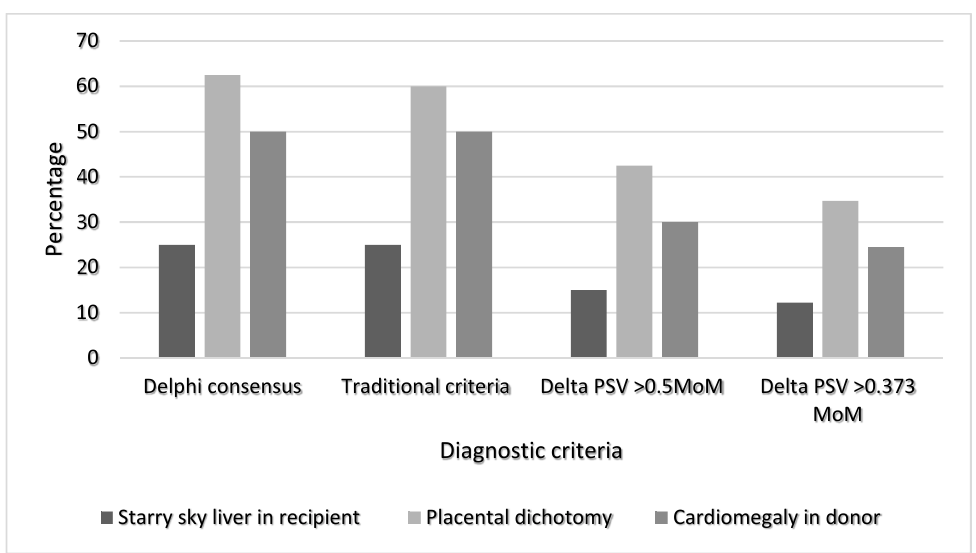
Figure 4. Bar chart showing the percentage presence of additional ultrasound markers such as starry sky liver in the recipient, placental dichotomy, and cardiomegaly in the donor in each of the four diagnostic criteria (Delphi consensus n = 16, Traditional criteria n = 20, Delta PSV >0.5MoM n = 40, Delta PSV >0.373MoM n = 49). These features were similarly prevalent in the Delphi and traditional criteria, but less prevalent in the delta PSV criteria.